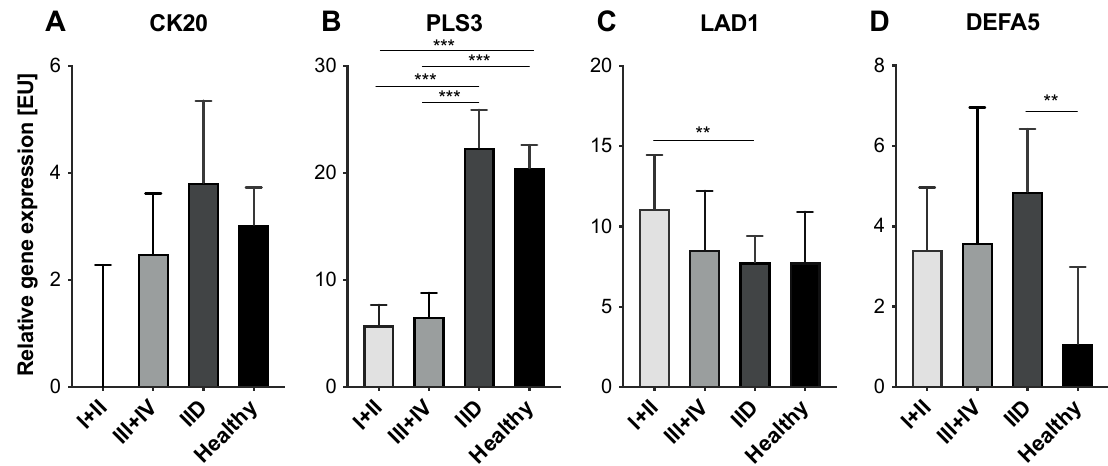
Figure 3. Expression levels of CTC-associated markers in blood samples of CRC patients with different tumor stages, IID patients and healthy controls. MNC-derived cDNA from n = 98 CRC patients, n = 64 IID patients and n = 40 healthy controls was analyzed by RT-qPCR for expression of ( A ) CK20, ( B ) PLS3, ( C ) LAD1, and ( D ) DEFA5. CRC patients were divided in patients with early-stage cancer (UICC I/II) and late-stage cancer (UICC III/IV). Data are presented as median and 95% confidence interval. ** p < 0.01; *** p < 0.001 .